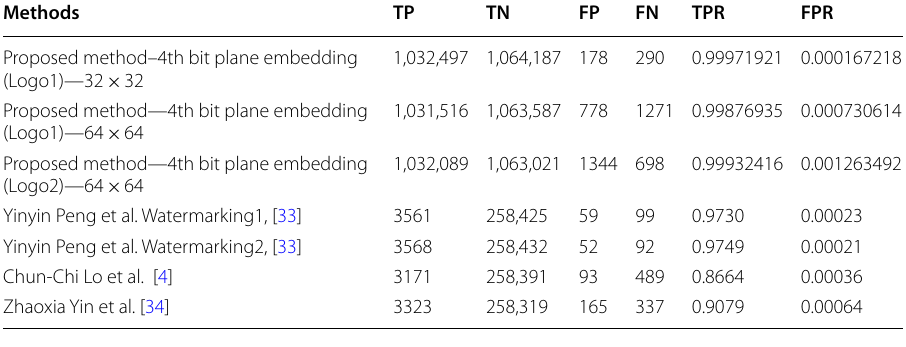
Table 6 Comparison of statistical parameters with the existing methodologies